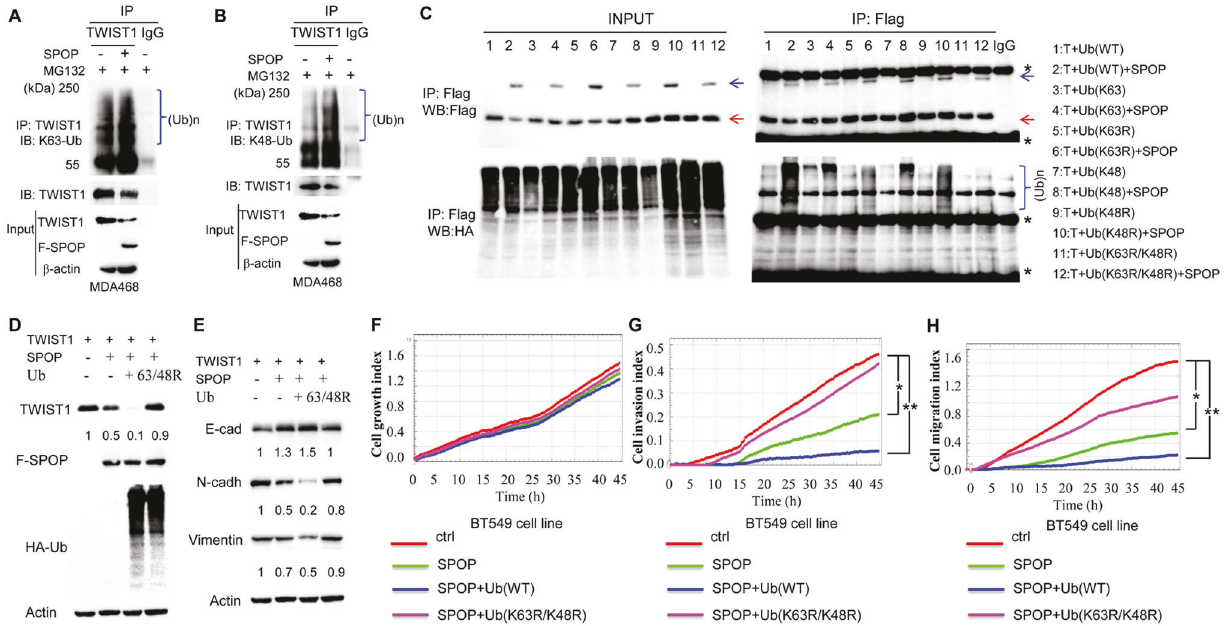
Fig. 6 SPOP promotes both K63-linked and K48-linked polyubiquitination of TWIST1. A SPOP promotes K63-linked ubiquitination (K63-Ub) of TWIST1. B SPOP promotes K48-linked ubiquitination (K48-Ub) of TWIST1. MDA-MB-468 cells (MDA468) were serum-starved, treated with MG132 for 2 h and lysed cells for IP with TWIST1 antibody, followed by IB analysis with indicated antibodies. C Both sites of K48 and K63 in ubiquitin are required for SPOP to promote ubiquitination of TWIST1. In vivo ubiquitination assay in TWIST1-inducible overexpressed cell transfected with Flag-tagged-SPOP along with MG132 treatment. T, TWIST1. Lane 1: TWIST1 + wild type ubiquitin Ub(WT), lane 2: TWIST1 + Ub(WT) + SPOP, lane 3: TWIST1 + Ub(K63), lane 4: TWIST1 + Ub(K63) + SPOP, lane 5: TWIST1 + Ub(K63R), lane 6:TWIST1 + Ub(K63R) + SPOP, lane 7:TWIST1 + Ub(K48), lane 8:TWIST1 + Ub(K48) + SPOP, lane 9:TWIST1 + Ub(K48R), lane 10: TWIST1 + Ub(K48R) + SPOP, lane 11:TWIST1 + Ub(K63R/K48R), lane 12:TWIST1 + Ub(K63R/K48R) + SPOP, lane IgG: IP with IgG. Red arrows, TWIST1, blue arrows, SPOP, and stars “ * ” , non-speci fi c. D Double mutations of both K63-linked and K48-linked ubiquitin Ub-K63R/K48R (63/48R) attenuated SPOP promoted TWIST1 degradation. TWIST1 inducible overexpressed cells were transfected with or without Flag-tagged-SPOP along with HA-Ub or double mutations of both K63-linked and K48-linked ubiquitination Ub-K63R/K48R (63/48R), and protein lysates were collected for western blotting analysis after doxycycline (Dox) treatments for one day. E Double mutations of both K63-linked and K48-linked ubiquitination Ub-K63R/K48R (63/48R) on TWIST1-attenuated SPOP promoted EMT marker regulation by stabilizing TWIST1. The same protein lysates from Fig. D were used for western blotting analysis. Double mutations of K63-linked and K48-linked ubiquitination Ub-K63R/K48R (63/ 48R) on TWIST1 attenuated SPOP promoted cell growth ( F ), invasion ( G ) and migration ( H ). BT549 cells were transfected with Flag-tagged TWIST1 with or without Flag-tagged-SPOP along with HA-Ub or double mutations of both K63-linked and K48-linked ubiquitination Ub-K63R/ K48R (63/48R), and real-time cell growth index, migration and invasion assays were performed in a real time cell analyzer. All experiments were repeated at least three times. “ * ” refers to p -value ≤ 0.05 and “ ** ” for p -value ≤ 0.01.